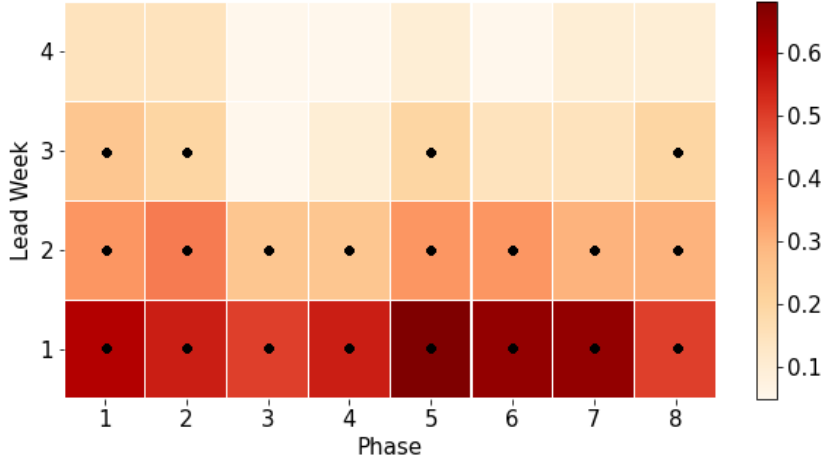
Figure 7. Averaged PCC of 15-member median MME prediction as a function of lead week and initial BSISO1 phase; results exceeding the 95% confidence level are dotted.